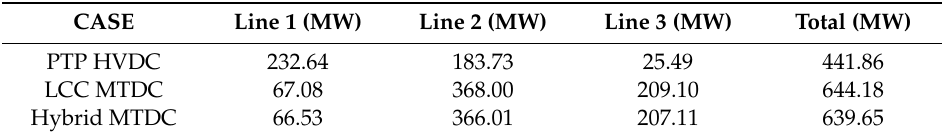
Table 2. Parallel AC transmission line power flow results of the third terminal 400 MW output.